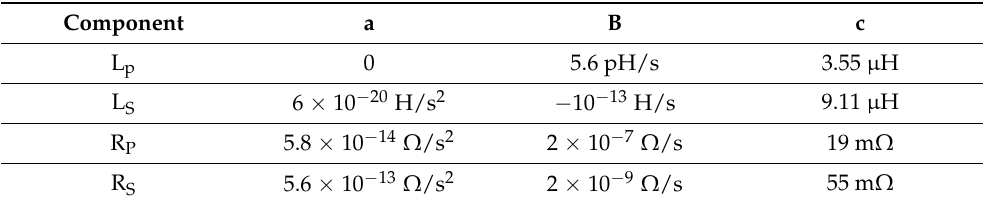
Figure 4. Tested WPT system with detailed diagrams of A and B blocks.